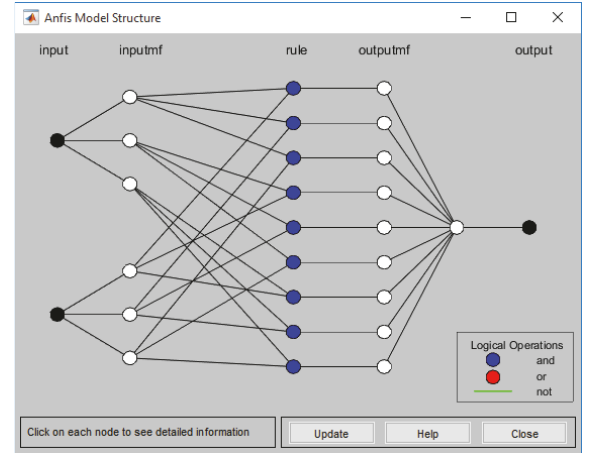
Figure 10: Structure of the proposed neurofuzzy controller in Matlab software, all nodes in five layers and links between them are